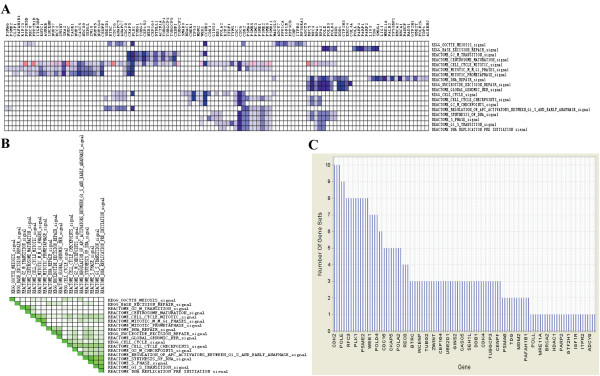
Leading edge analyses for the gene sets related to cell cycle identified in comparison between HCV/HIV co-infected group and HCV mono-infected group. Gene sets related to cell cycle control identified in comparison between HCV/HIV co-infected group and HCV mono-infected group were analyzed by the leading edge analyses of GSEA software. A. The heat map shows the genes in the leading edge subsets. In a heat map, expression values are represented as colors, where the range of colors (red, pink, light blue, dark blue) shows the range of expression values (high, moderate, low, and lowest); B. The Set-to-Set maps use color intensity to show the overlap between subsets: the darker the color, the greater the overlap between the subsets; C. graph shows each gene and the number of subsets in which it appears.